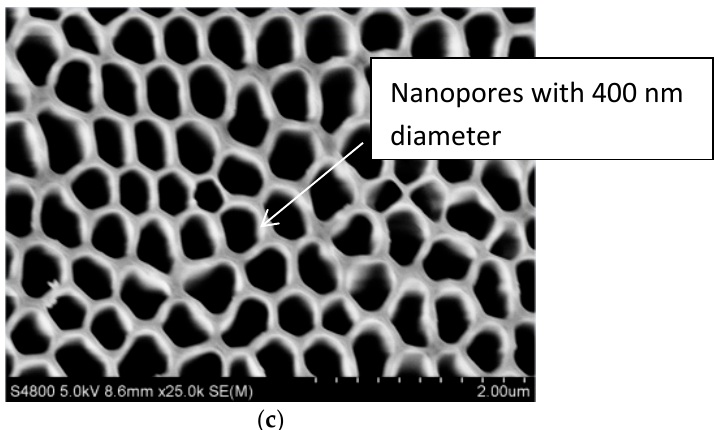
Figure 5. The SEM image of the aluminum sheet. ( a ) polished aluminum sheet; ( b ) nanopores with 30 nm diameter; ( c ) nanopores with 400 nm diameter.